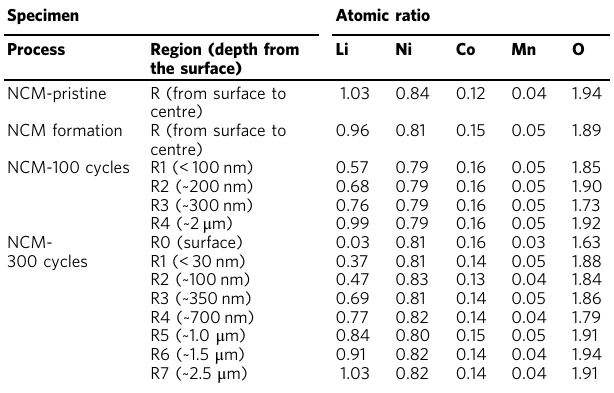
Fig. 2 shows the charge – discharge curves of the cell cycled in the voltage range of 2.8 – 4.35 V at 0.2 C and 45 °C as a formation process (hereafter, the corresponding cell is referred to as NCM